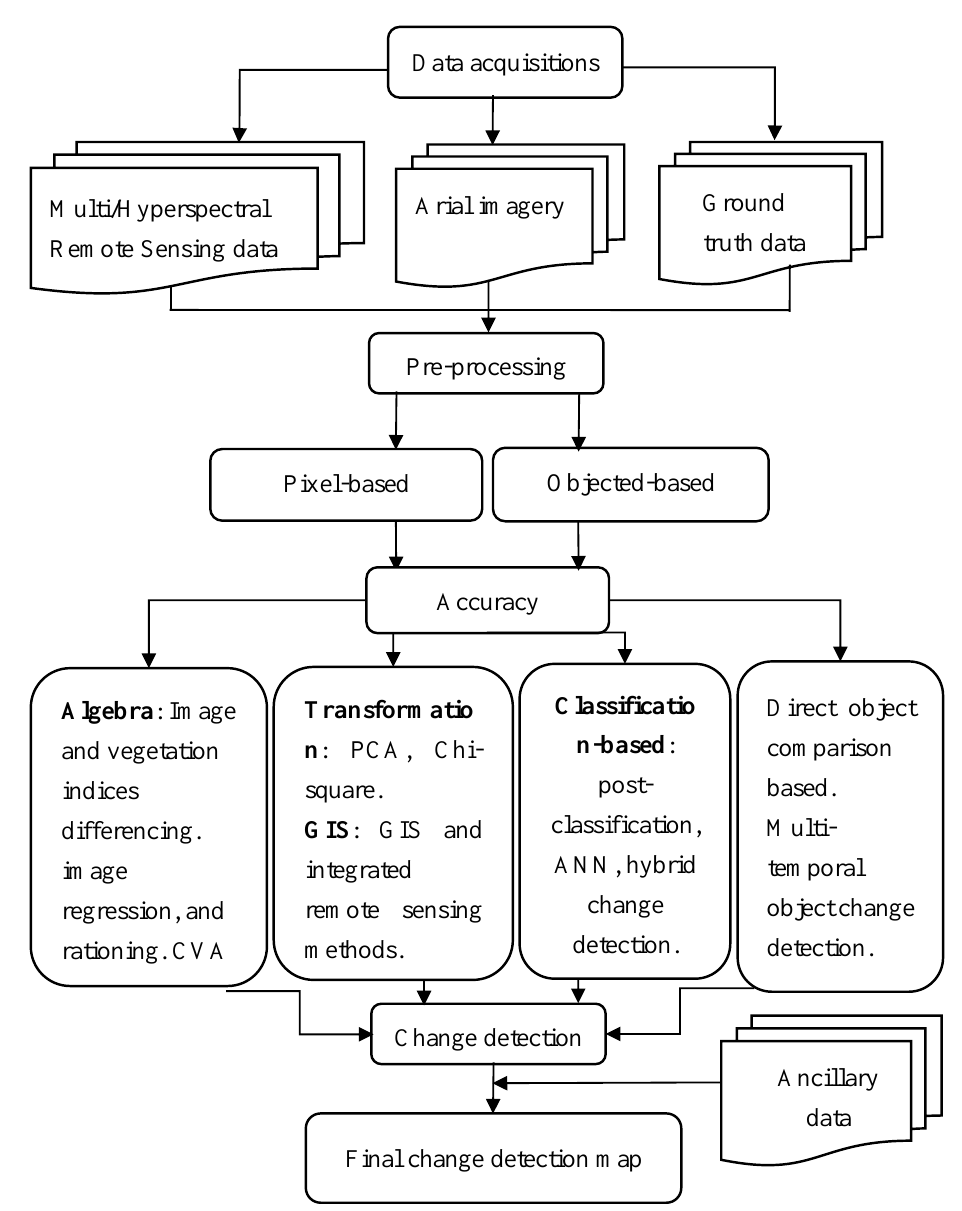
Figure 1. Commonly used methods to detect land cover changes include different types of classifi- cation and change detection methods.